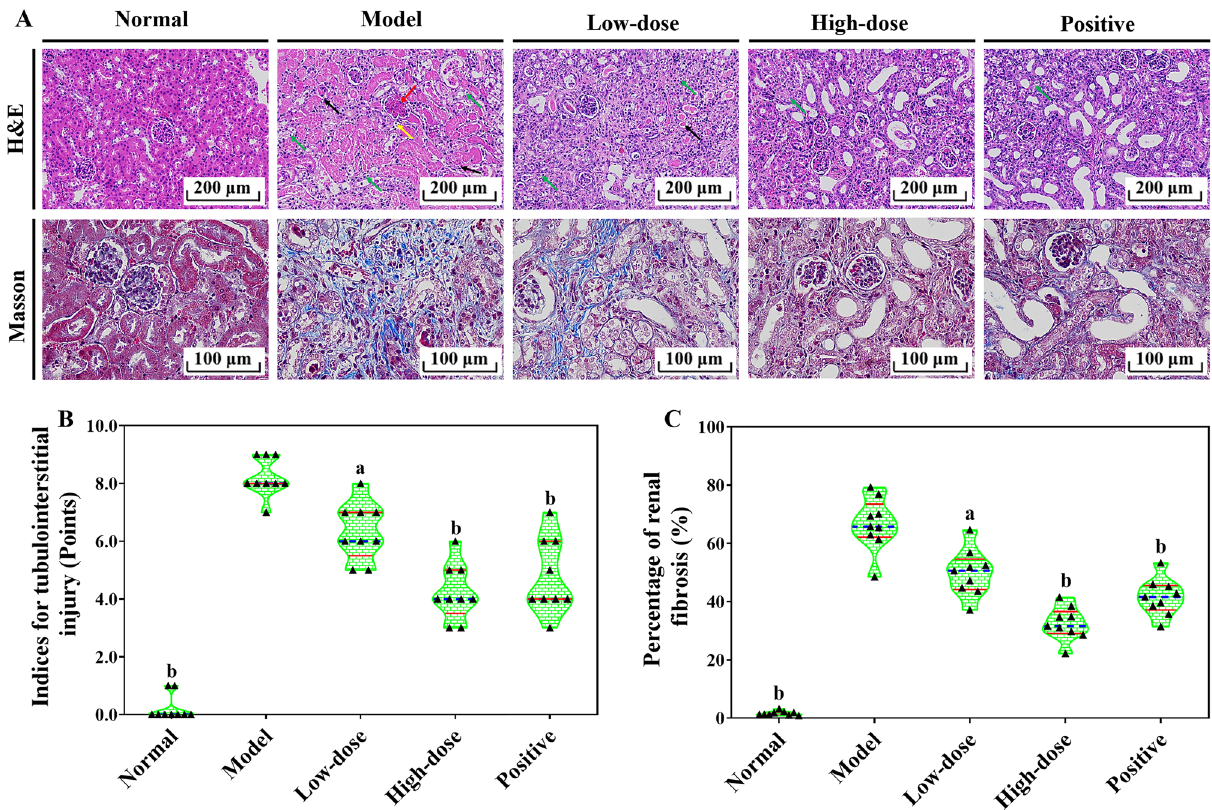
Figure 4. The effects of COS on the development of tubulointerstitial fibrosis in UUO-induced RF mice. Representative micrographs illustrating of H&E and Masson trichrome staining from kidney tissues ( A ). The tubulointerstitial injury score based on H&E staining ( B ). Percentage of the Masson trichrome-positive tubulointerstitial area relative to the entire area ( C ). The different colored arrows in Fig. 5A indicated the following meanings. The Black arrows implied necrosis of the tubular epithelial cells or hyperchromatism or disintegration of the nucleus or increased eosinophilic cytoplasm. The red arrows represented structural damage to the glomerulus or congestion of capillaries in the glomerulus. The yellow arrows showed inflammatory cells oozing out. The green arrows meant the epithelial cells of the renal tubules are edema and swollen, and the cytoplasm is loose, stained or vacuolar. All values are represented as mean ± SD (n = 10 in each group). Superscript letters a and b designate significant differences. a P < 0.05 compared with the model group. b P < 0.01 compared with the model group.